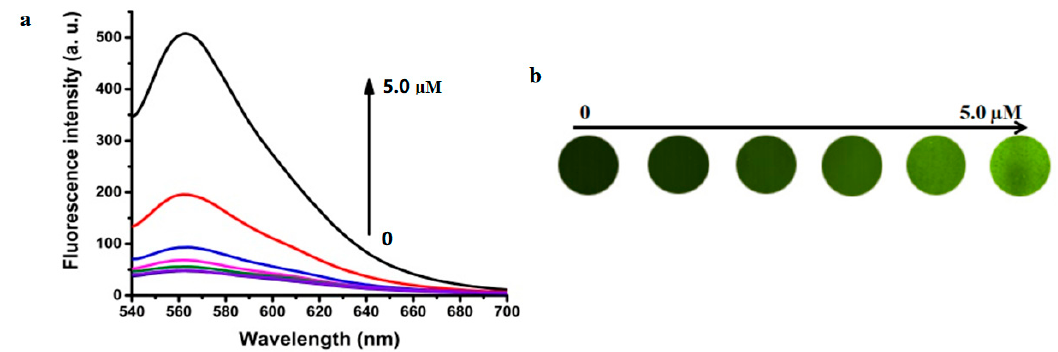
Figure 4. TEM images of RB-AuNPs (3.0 nM) added with various amount of ethoprophos. The scale bar is 100.0 nm.